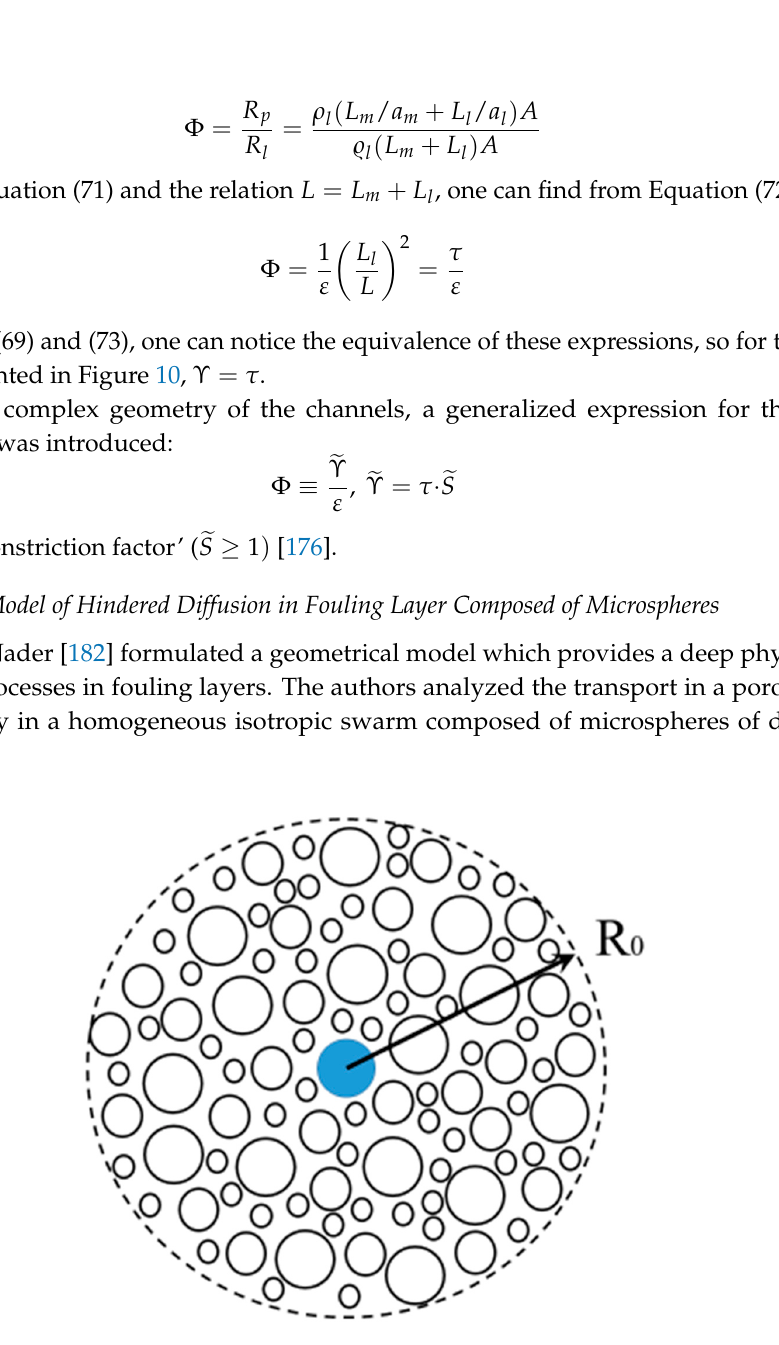
Figure 11. A sketch of homogeneous and isotropic swarm of microspheres of porosity ε illustrating the geometrical model [182]. The figure shows cross sections running through the center of a reference microsphere (marked with blue) of radius R 1 and an outer sphere with radius R 0 (a concentric shell, marked with a dotted line).